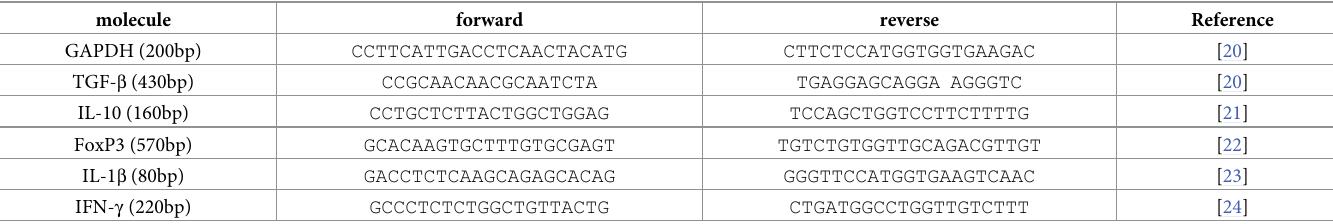
Table 1. Molecules and primer sequences for PCR